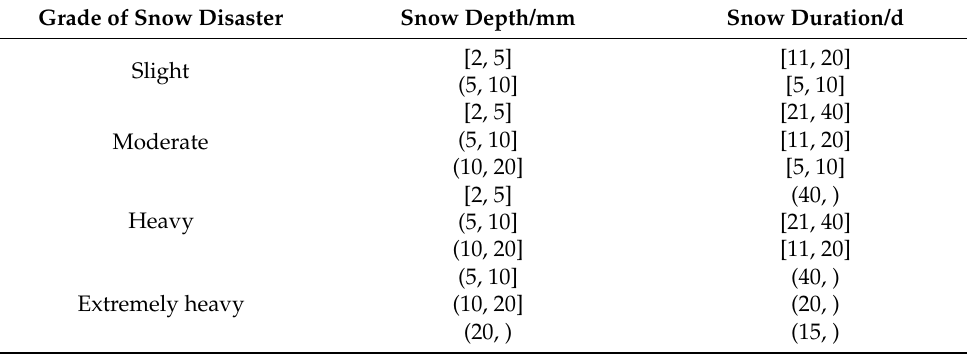
Table 1. Division criteria for snow disasters of last